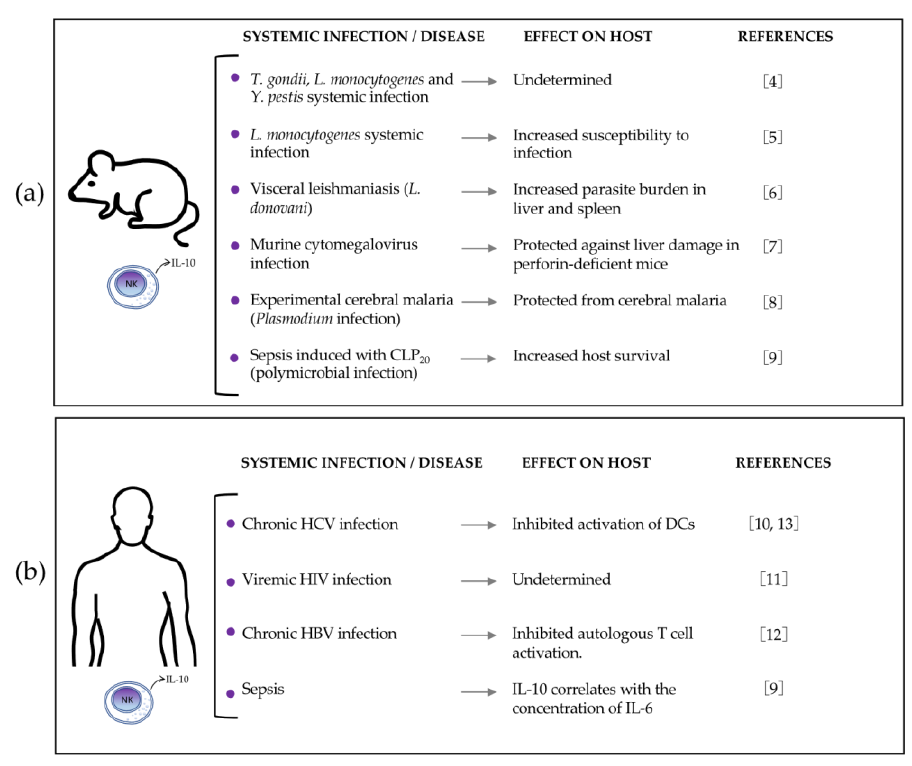
Figure 1. Natural killer (NK) cells produce interleukin-10 (IL-10) during diverse systemic infection models and some diseases in humans. The figure shows the ( a ) mouse models, and ( b ) human diseases in which NK cells are main producers of IL-10, and the observed effect on the host. CLP— cecal ligation and puncture; CLP20—cecal ligation and puncture with 1 puncture; HCV—hepatitis C virus; HBV—hepatitis B virus; HIV—human immunodeficiency virus; DCs—dendritic